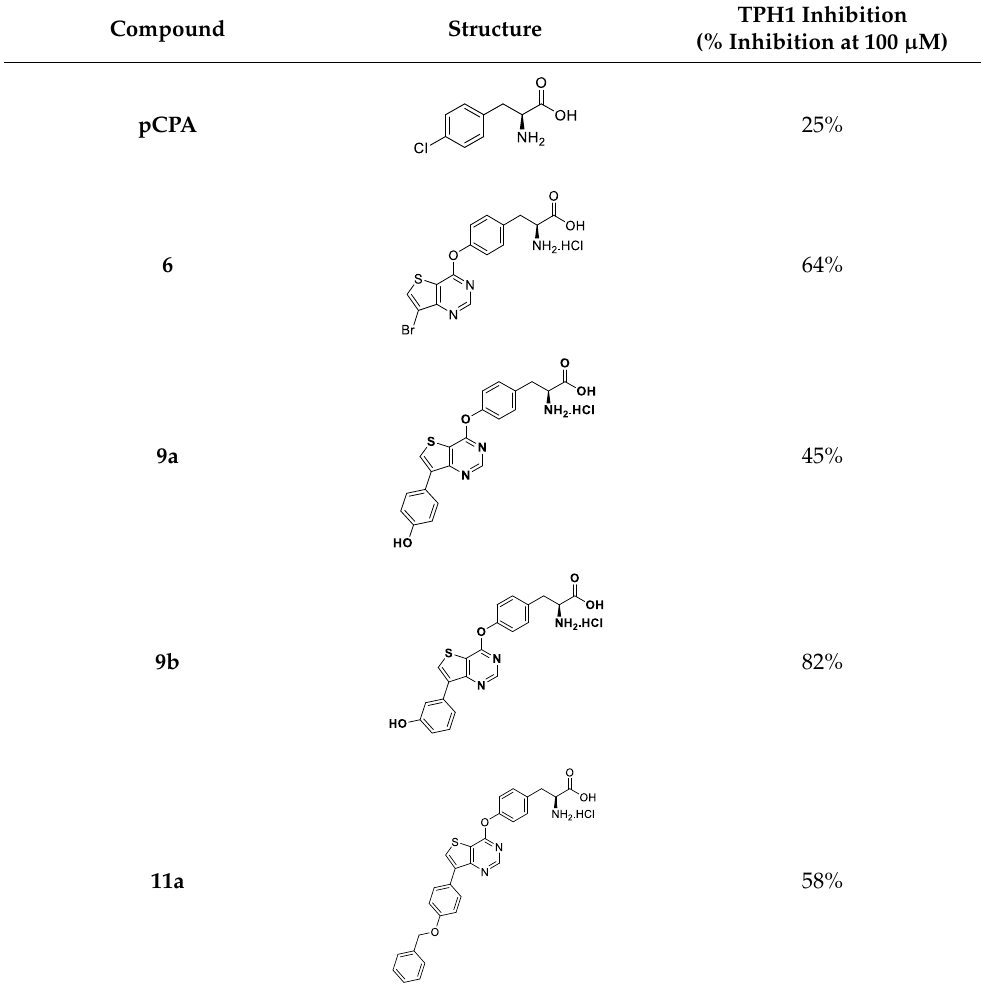
Table 1. In vitro test of thienopyrimidine derivatives.